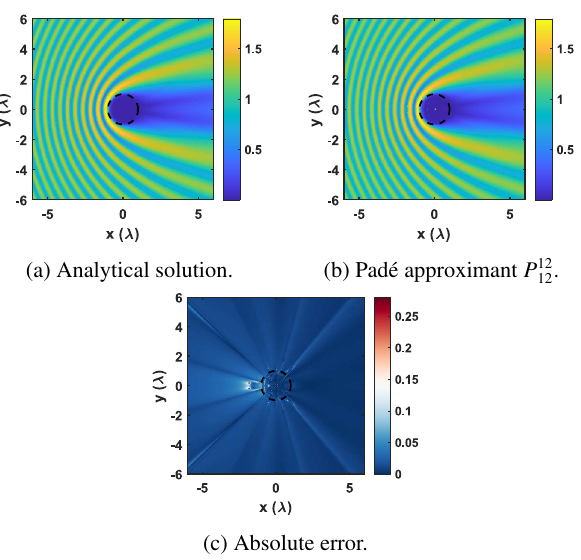
Figure 2: Born-Padé solution for a silver cylinder of radius 400 nm at a wavelength of 400 nm. The plots display the absolute value. The axes are relative to the wavelength.